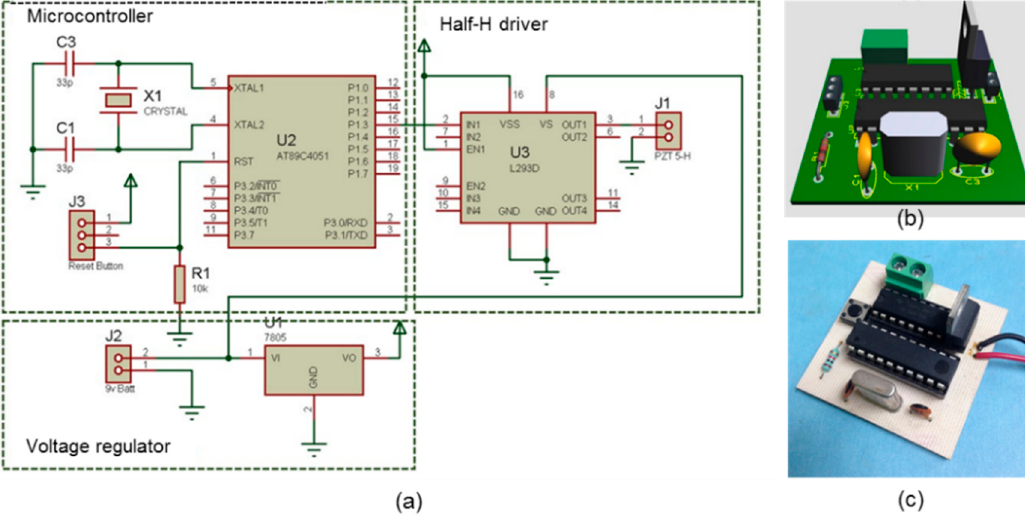
Figure 6. Electronics design and construction of the PPM generator. ( a ) Schematic diagram; ( b ) PCB design; and ( c ) actual PPM generator.